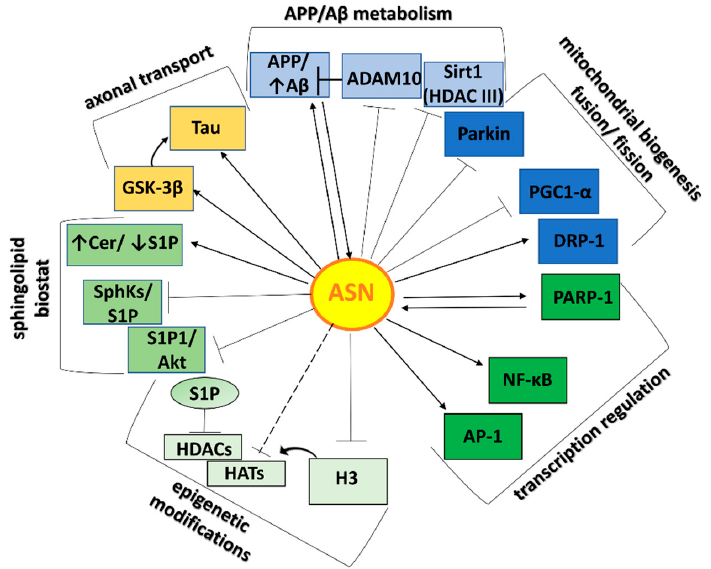
Figure 4. Potential targets for PD neuroprotective strategies associated with sphingolipid signaling and anti-oxidative defense. Arrows terminating with → represent activation, while those terminat- ing with ┴ represent inhibition/deterioration. Abbreviations: PD-Parkinson’s disease; ASN—alpha- synuclein; Sirt1—silence information regulator 1 (sirtuin 1); OS—oxidative stress; CER—ceramide; sphingosine kinases were abbreviated as Sphks. However, inhibition under OS conditions mainly affects the Sphk1 isoform synthesizing the S1P pool acting through S1P receptors [9], while Sphk2 synthesizes S1P-inhibiting HDACs. The dashed line connecting S1P ( ↓ S1P) with HDAC1, HDAC2 determines that S1P is an endogenous inhibitor of HDACs, and its decline partially abolishes HDACs inhibition while leading to increased histone deacetylation [90].